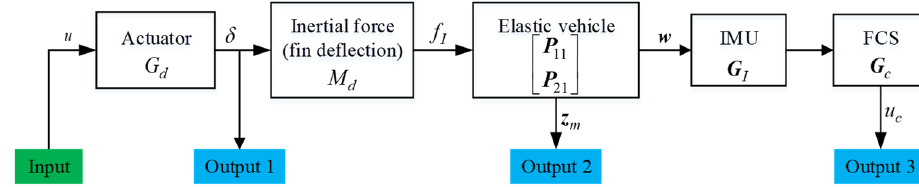
Figure 7. Block diagram of fin excitation.